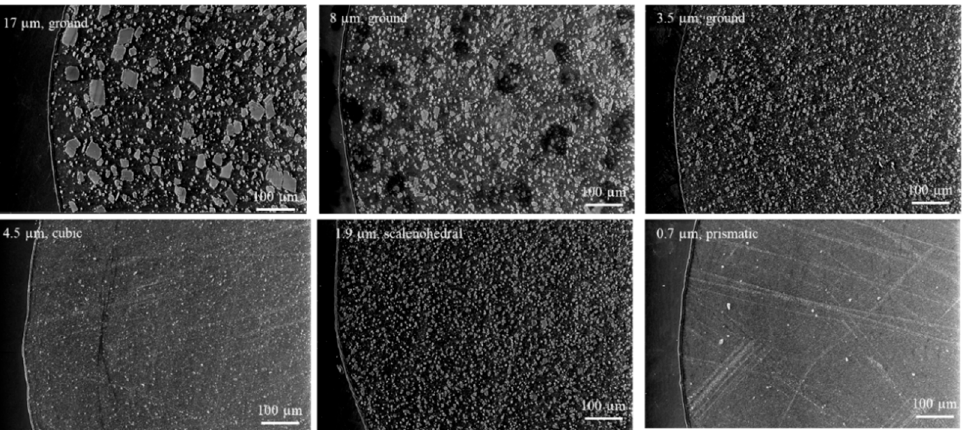
Figure 4. ESEM images of EVA/CaCO 3 injection-molded implant samples cross-sectioned perpen- dicular to flow.